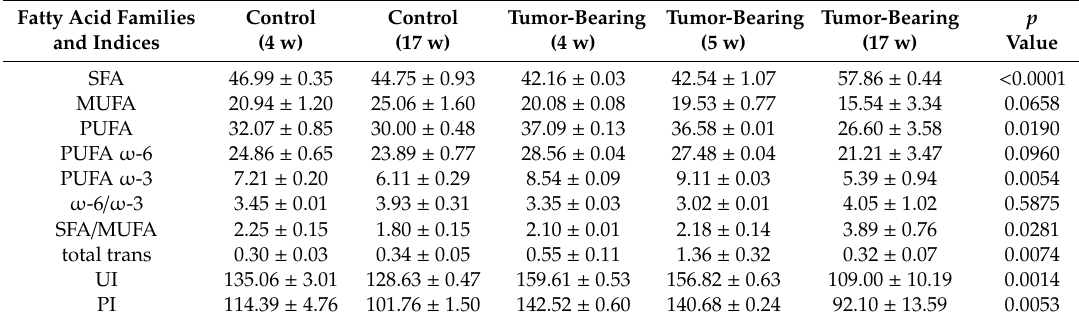
Table 4. Fatty acid families and indices (obtained from the fatty acid values of Table 3 of control SCID mice (4- and 17-weeks) and tumor-bearing SCID mice at di ff erent age points (4-, 5- and 17-weeks). Fatty Acid Families and